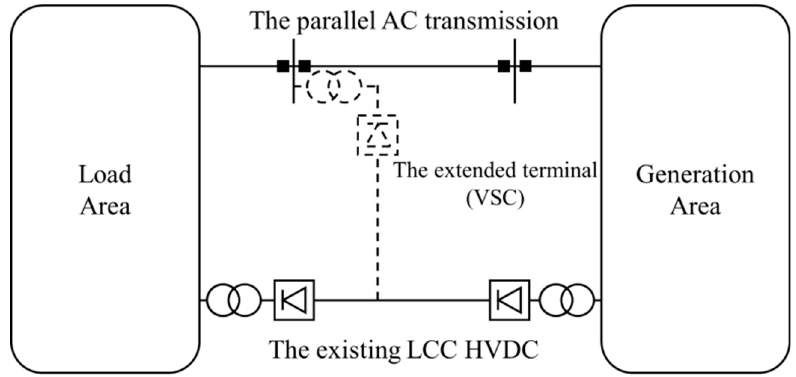
Figure 1. Extended multi-terminal high voltage direct current (MTDC) application in the power system between the generation and load areas.